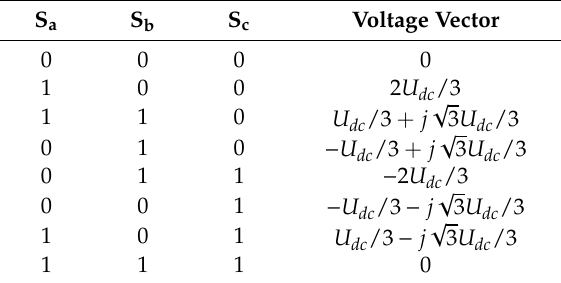
Table 1. Switching states and voltage